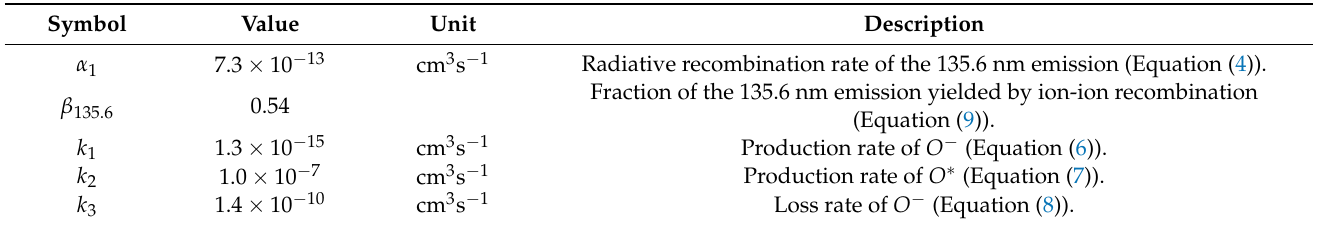
Table 2. The rate coefficients for photochemical reactions of the 135.6 nm airglow emission [44,45].